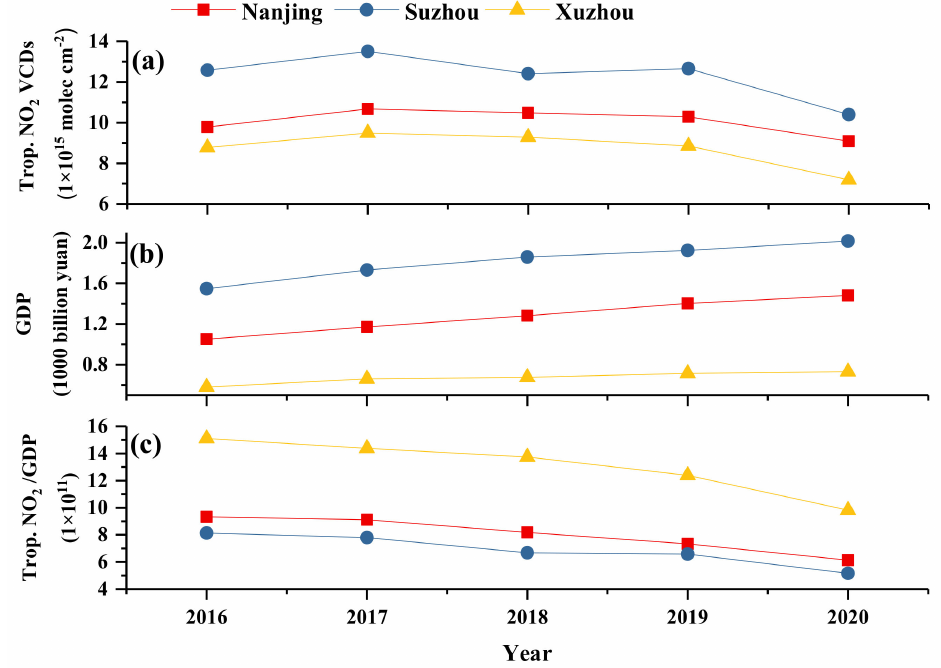
Figure 3. The annual variation of tropospheric NO 2 VCDs ( a ), gross domestic product (GDP) ( b ), and the ratio of tropospheric NO 2 VCDs to GDP ( c